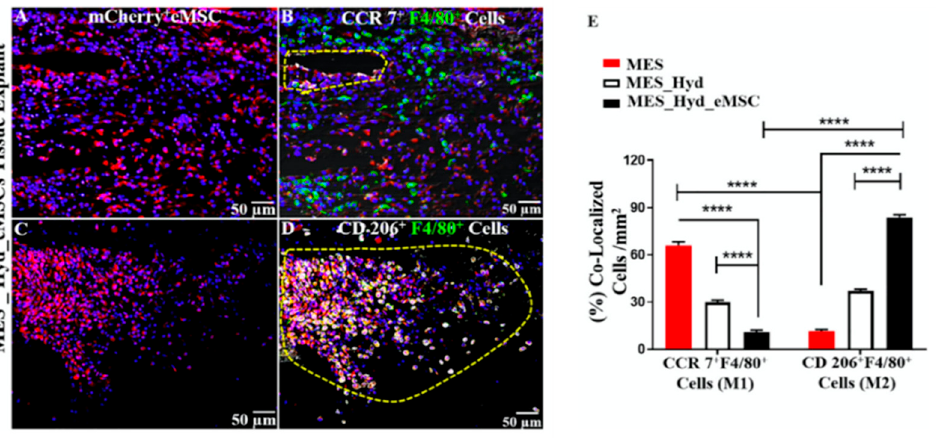
Figure 8. Immune response and infiltration of host cells into melt electrospinning (MES) mesh. ( A – D ) Immunofluorescence showing m-Cherry+ eMSCs labelled (pink) and recruitment of CCR7+ (M1) and CD206+ (M2) macrophages in an explant after 1 week. ( E ) Quantified chart showing co-localisation of M1/M2 macrophages. Figure shows that the presence of eMSCs was consistent with a reduction in inflammatory M1 macrophages and an increase in healing M2 macrophages. ( ∗∗∗∗ , p < 0.0001). Reproduced with permission from [55] .